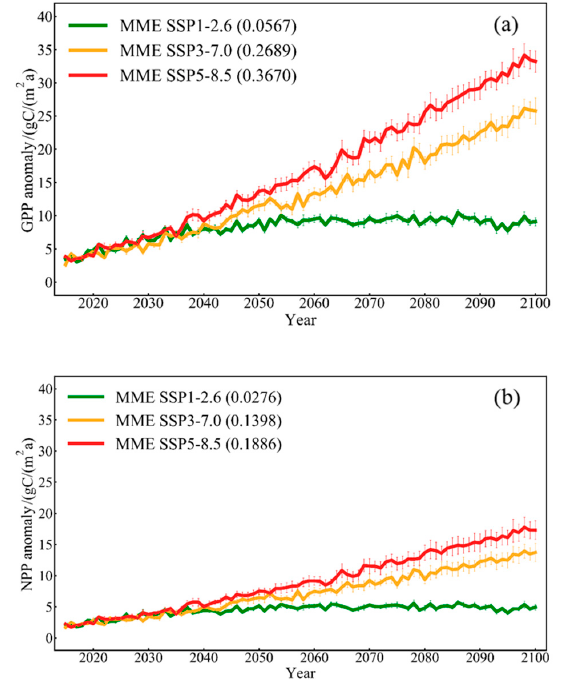
Figure 1. The regionally averaged annual GPP anomaly is shown in ( a ); the annual NPP anomaly is shown in ( b ) (units: gCm − 2 a − 1 ). They are over the Qinghai-Tibet Plateau during 2015–2100 relative to 1951–2014 under the SSP1-2.6, SSP3-7.0 and SSP5-8.5 scenarios as derived from five models and their ensemble mean with the same weights (MME). The tendency rates of GPP and NPP are shown in the legend.